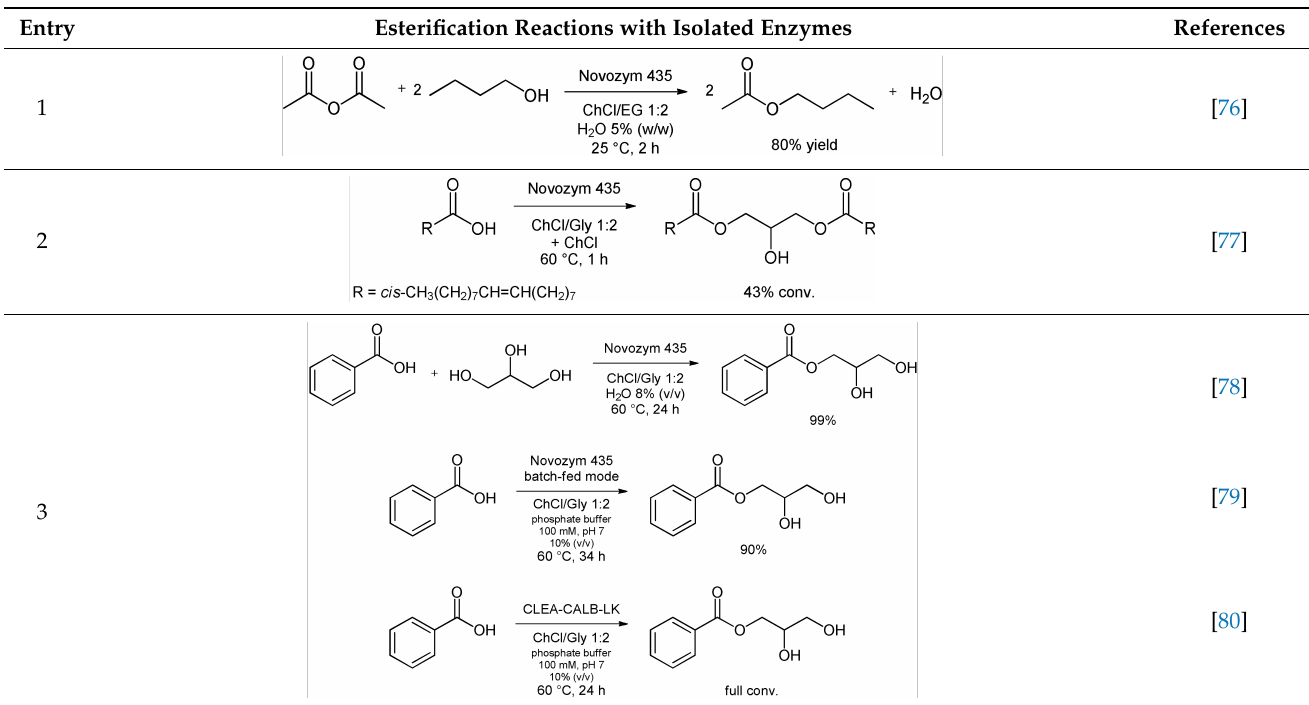
Table 7. Esterification reactions with isolated